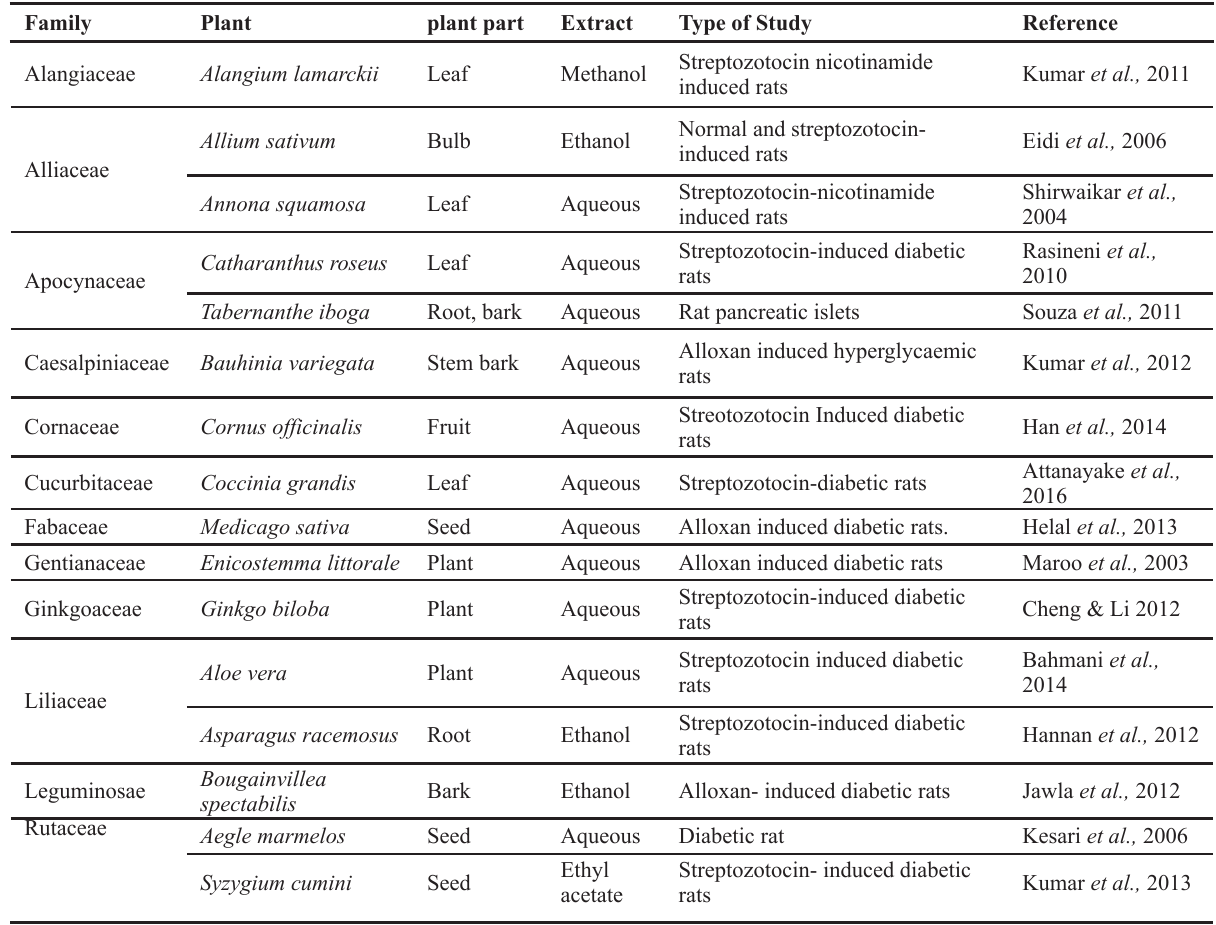
Table 1: A summary of antidiabetic plants which were recently scrutinized by scientific investigations.